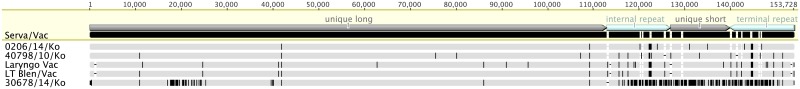
Complete genome alignment between the Korean field strains of ILTV and ILTV vaccine strain.The Serva vaccine was used as a reference. The alignment was performed using MAFFT. Vertical black lines represent single-nucleotide differences, and dashes represent gaps.